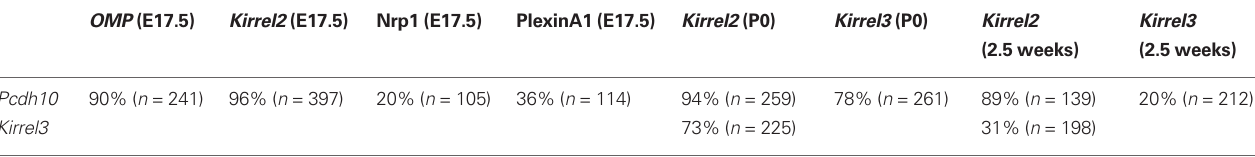
Table 1 | Double-label in situ hybridization with pcdh10 and other activity-regulated genes .